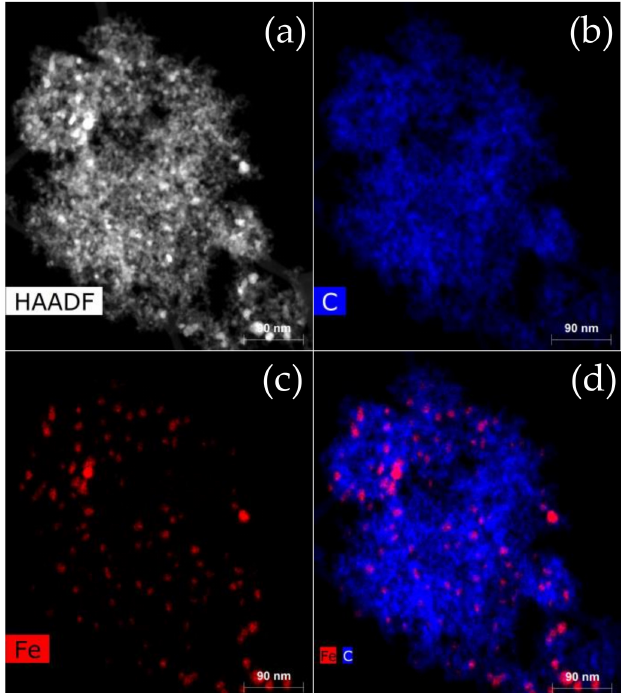
Figure 4. HAADF microscopy image from a certain nanotemplate cluster of the NHD-750 sample ( a ) with specific elemental mapping of C ( b ); Fe ( c ) and Fe & C ( d